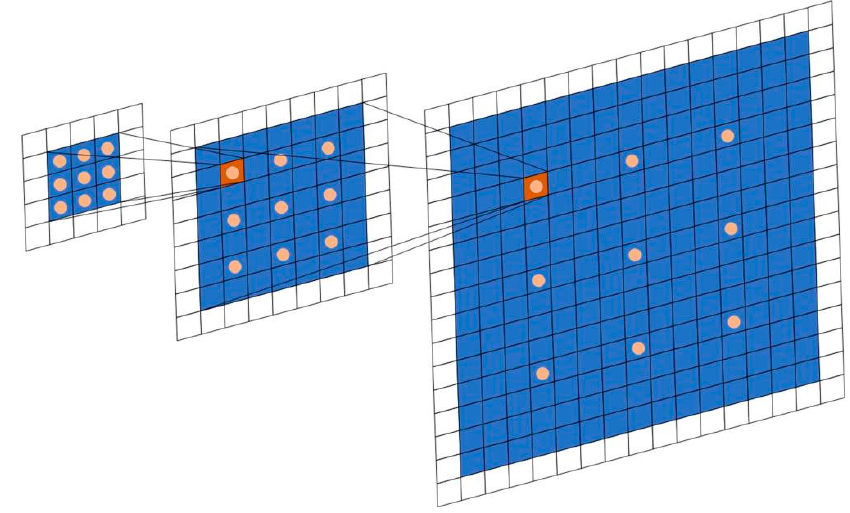
Figure 4. Schematic diagram of the atrous convolution.